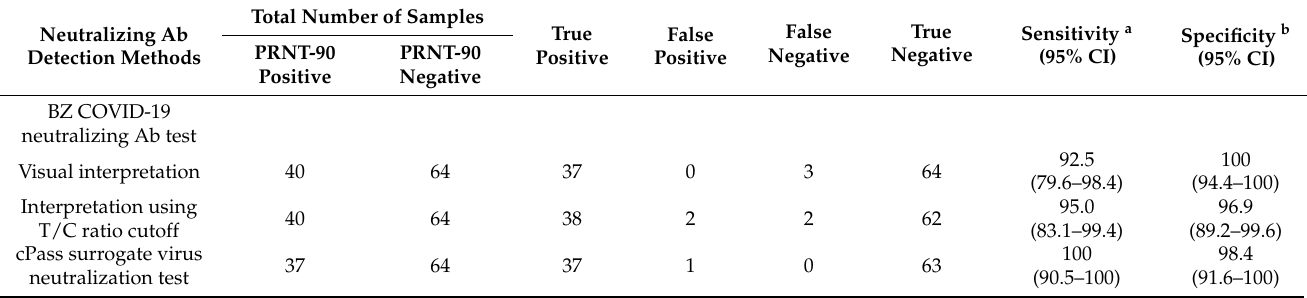
Table 1. Performance comparison of the BZ COVID-19 neutralizing antibody test and cPass surrogate viral neutralization assay.